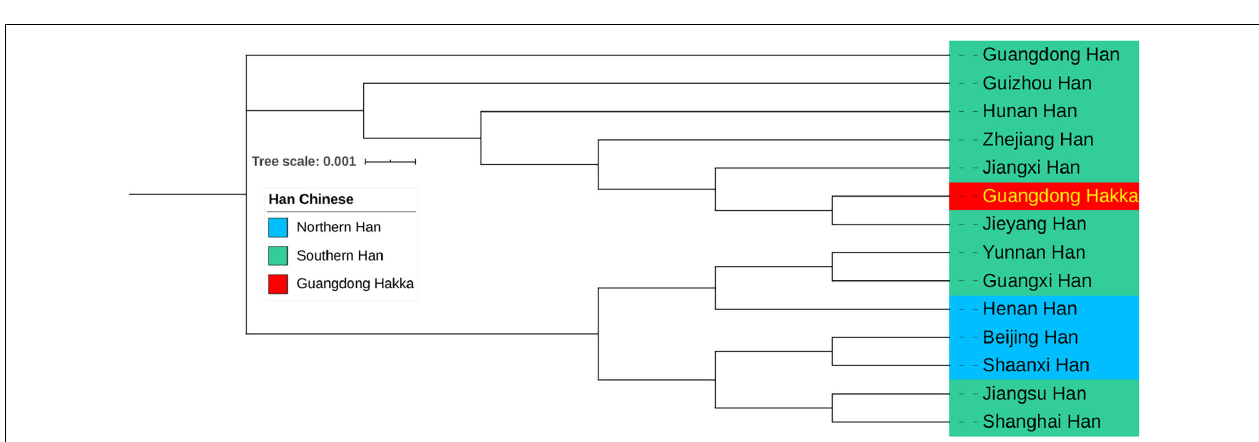
FIGURE 4 | Multidimensional scaling (MDS) plots based on the frequencies of 23 Y-STRs among Guangdong Hakka, Guangdong She, and 159 worldwide human populations (including 83 Chinese populations). (A) Euclidean-based MDS plot in worldwide populations from geographical scale. (B) Euclidean-based MDS plot in worldwide populations from linguistic scale. (C) Manhattan-based MDS plot in worldwide populations from geographical scale. (D) Manhattan-based MDS plot in worldwide populations from linguistic scale. (E) Euclidean-based MDS plot in Chinese populations from geographical scale. (F) Euclidean-based MDS plot in Chinese populations from linguistic scale. (G) Manhattan-based MDS plot in Chinese populations from geographical scale. (H) Manhattan-based MDS plot in Chinese populations from the linguistic scale.